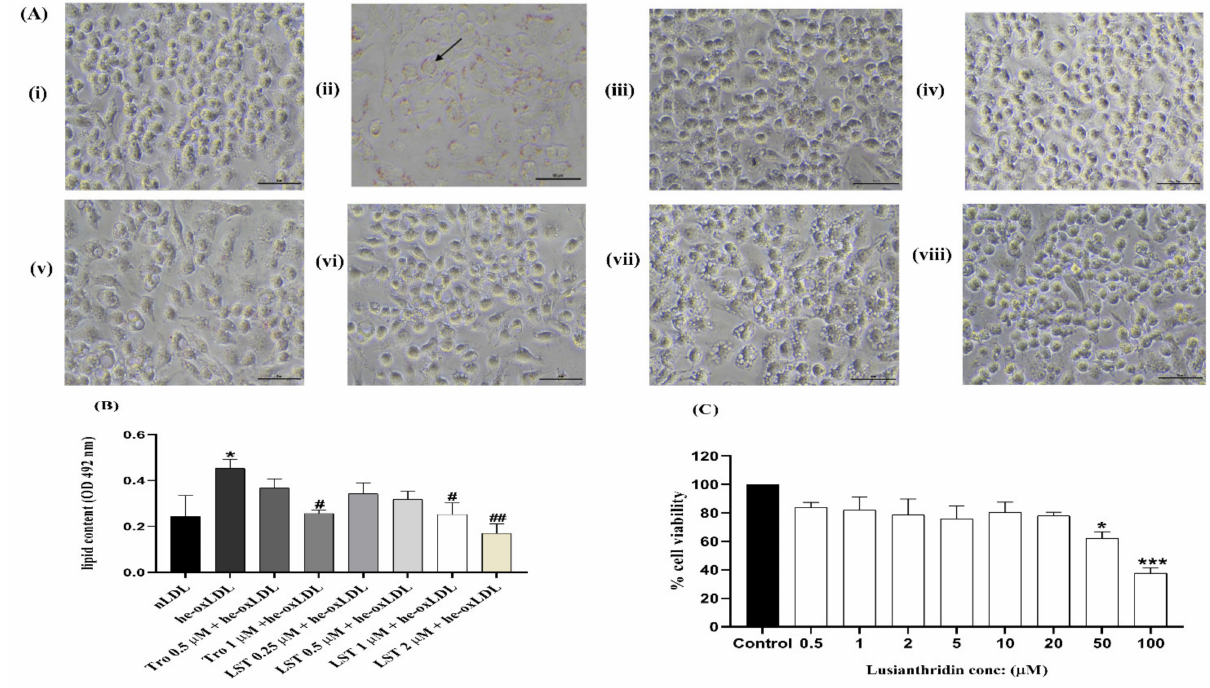
Figure 5. ( A ) Representative Oil Red O photographs of RAW 264.7 macrophage cells (40 × magnification) (i) nLDL, (ii) he-oxLDL, (iii) TRO 0.5 µ M, (iv) TRO 1 µ M, (v) LST 0.25 µ M, (vi) LST 0.5 µ M, (vii) LST 1 µ M, (viii) LST 2 µ M. ( B ) Quantitation of lipid content at 492 nm. Data were presented as mean ± SEMs ( n = 4); * p < 0.05 vs . nLDL; # p < 0.05 and ## p < 0.0001 vs . he-oxLDL. ( C ) Effect of lusianthridin on RAW 264.7 macrophage cell viability. * p < 0.05 and *** p < 0.0001 vs .